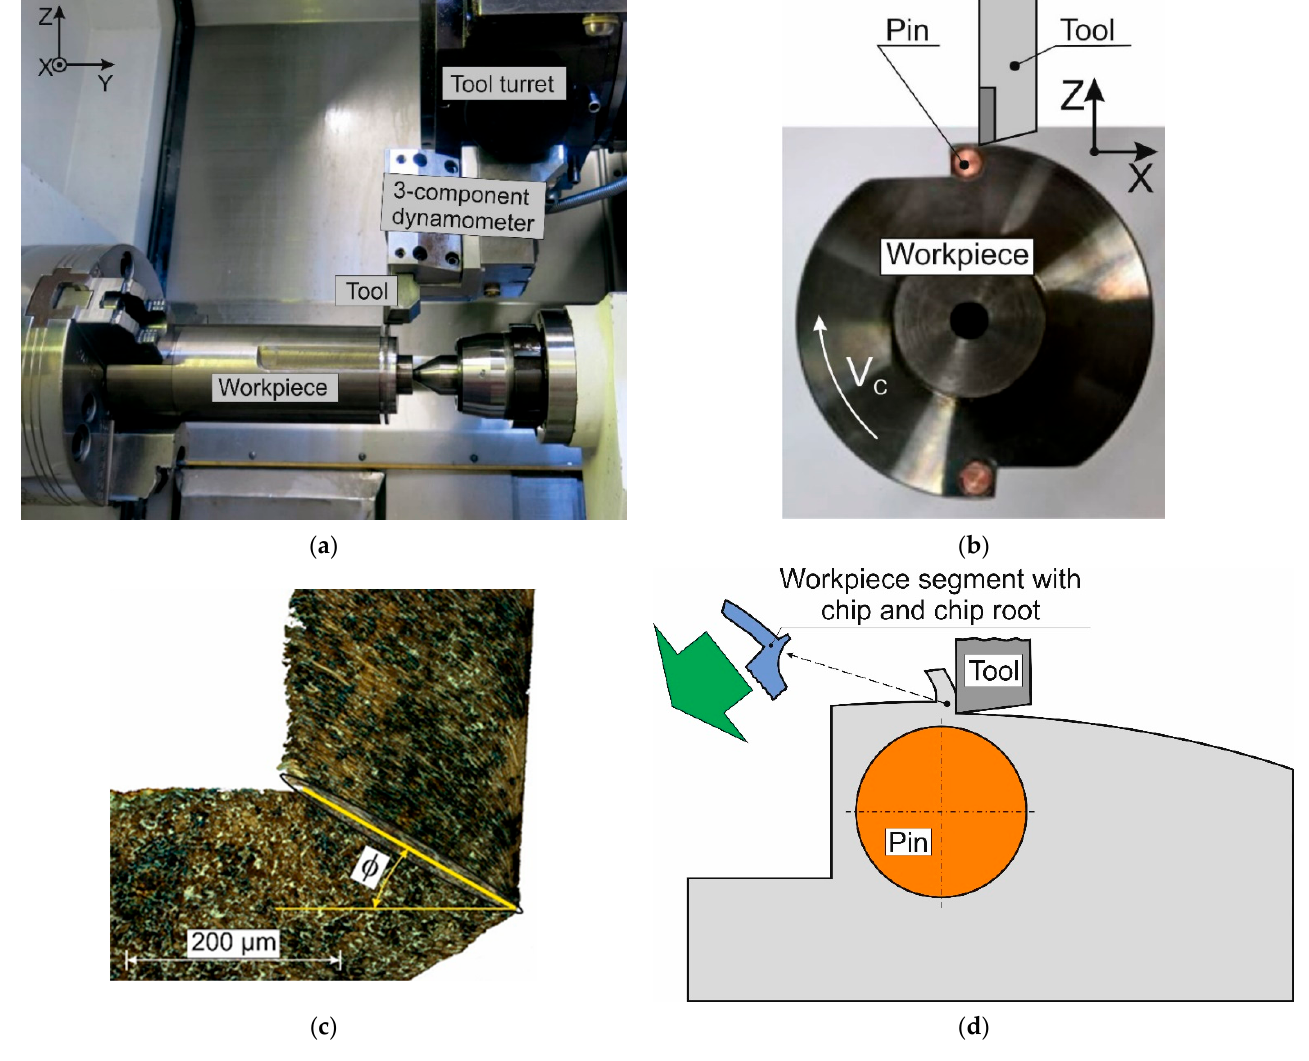
Figure 2. Experimental set-up for cutting forces measurement: ( a )—experimental setup; ( b )—basic view of the workpiece with the tool to obtain the chip root; ( c )—chip root; ( d )—scheme of obtaining the chip